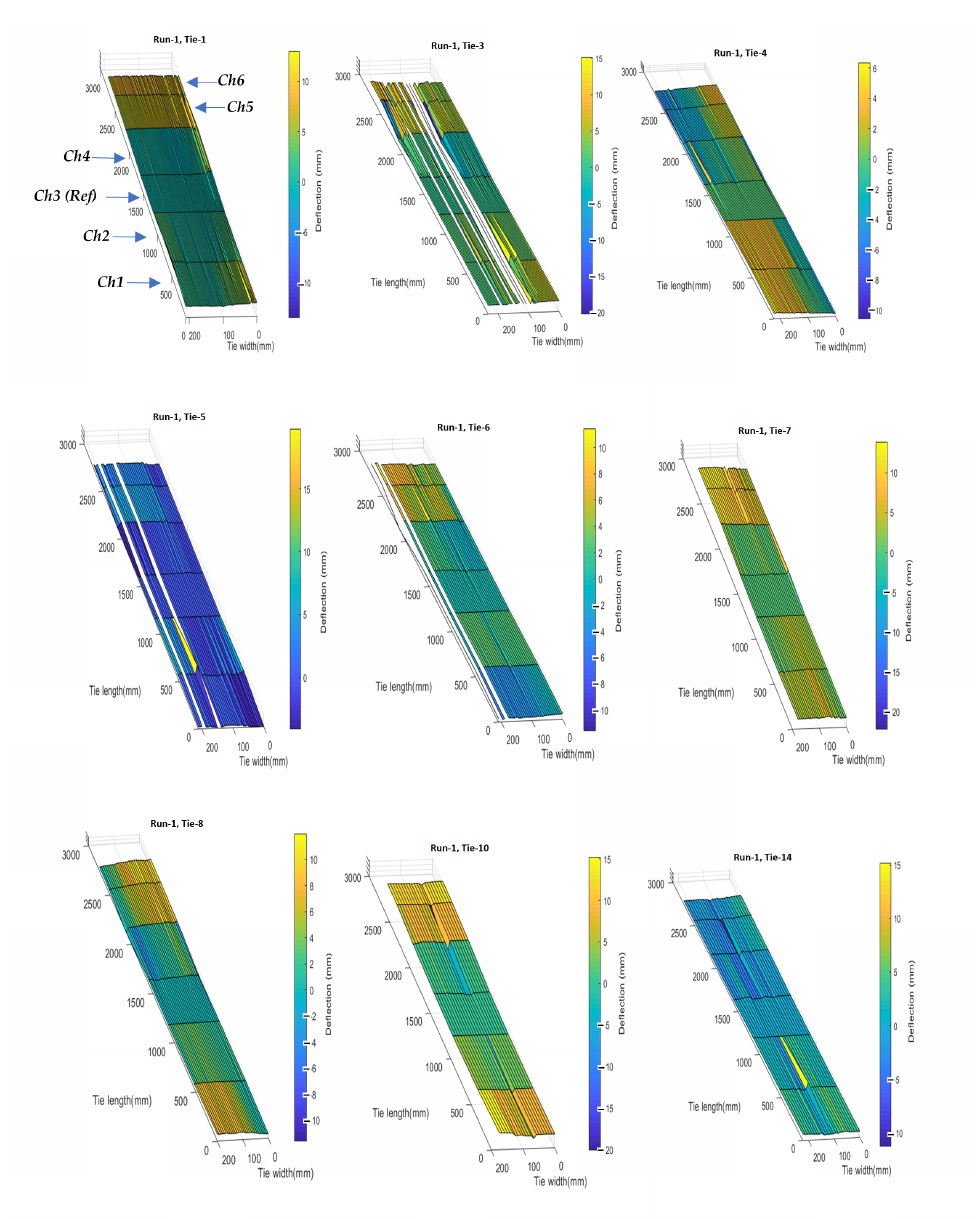
Figure 16. Full-field deflection profiles of nine ties scanned in a test